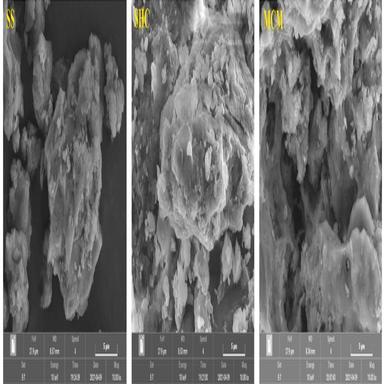
SEM images of sewage sludge (SS), sludge hydrochar (SHC) and the prepared mesoporous carbon material (MCM).